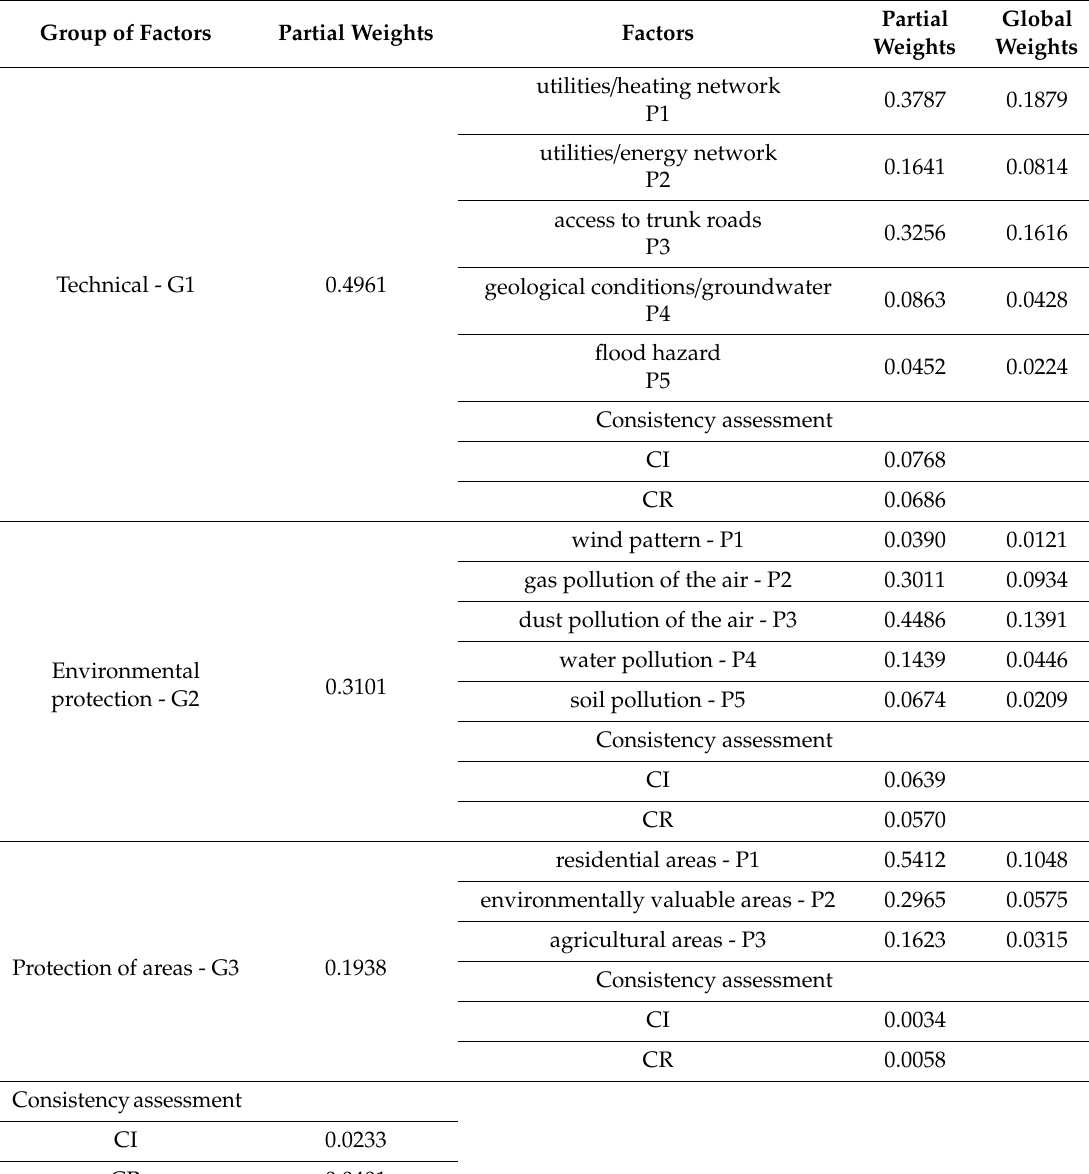
Table 5. Weight priorities at particular